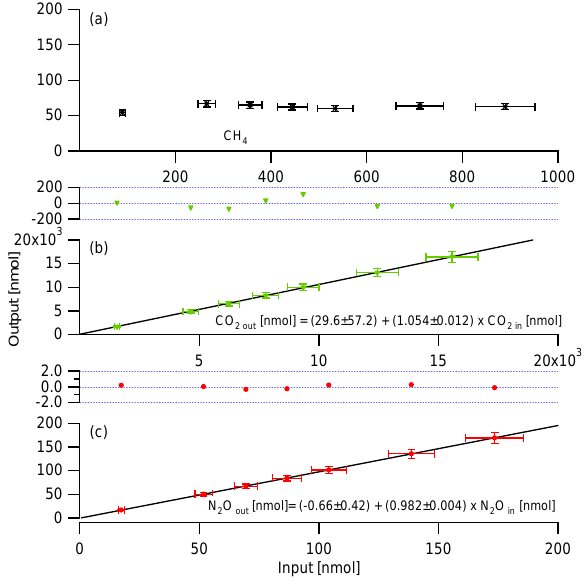
Fig. 4. Amount of (a) CH 4 , (b) CO 2 , and (c) N 2 O concentrated on the HayeSep D trap depending on the sample volume from 1 to 10l (adsorption: 100sccm of 390ppb N 2 O, 35ppm CO 2 , 2.0ppm CH 4 , 350ppb CO, 25ppm H 2 O in 80% N 2 and 20% O 2 ) . Error bars represent the expanded standard uncertainty. For CO 2 and N 2 O deviations from linearity are given